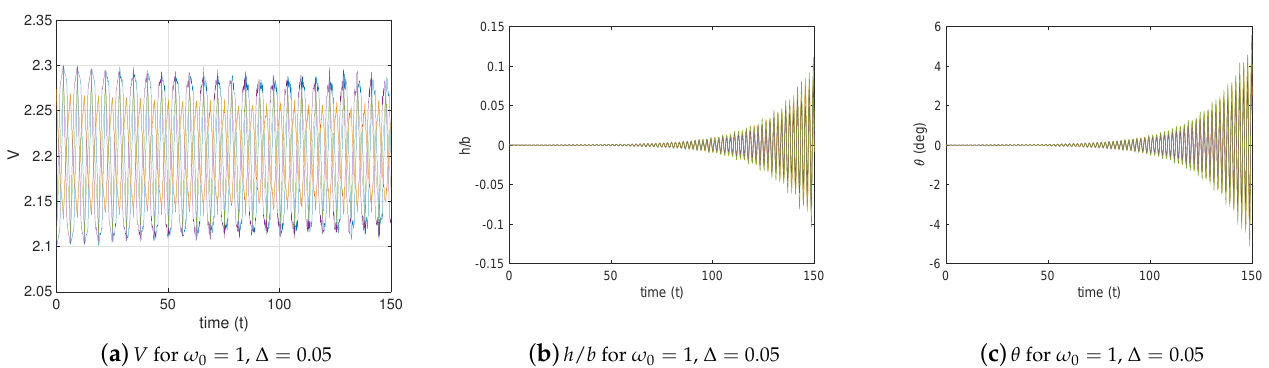
Figure 15. Oscillation of the airfoil with correlation function, r xx = Cos ( ω 0 τ ) , where ω 0 = 1, ∆ = 0.05, and V ave = 2.2.